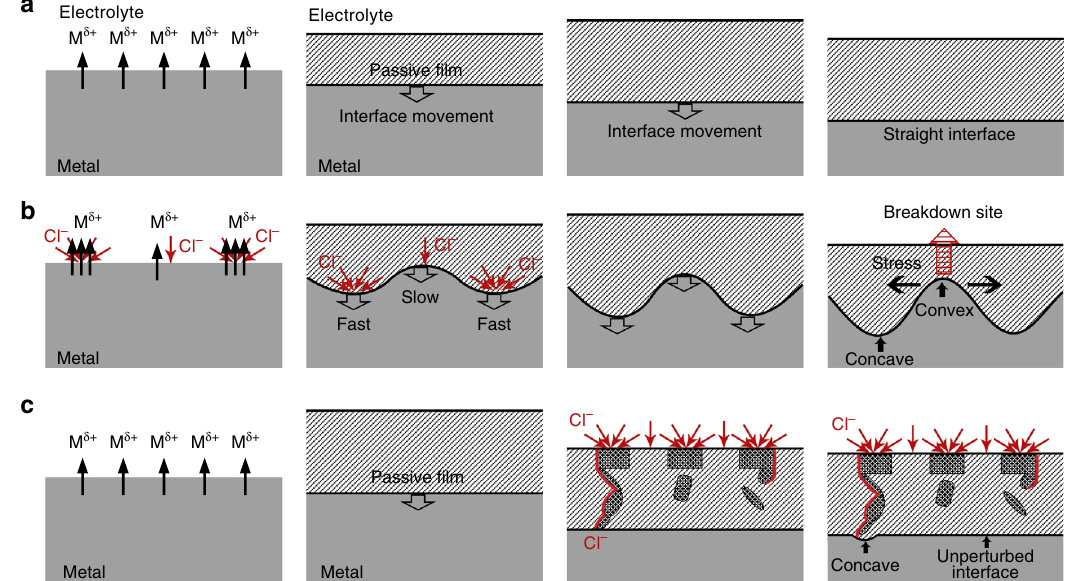
Fig. 7 Schematic maps illustrating interface evolution in the absence and presence of chloride ions. The fi lm growth process involves transport of both injected metal ions from the matrix and oxygen in solution through the barrier layer, causing the metal/ fi lm (Me/BL) interface to move toward the metal matrix side. a In chloride-free (0.5 mol L − 1 H 2 SO 4 ) electrolyte, the austenitic matrix experienced selective dissolution of metal ions (major Fe) in a somewhat homogeneous manner, yielding a straight Me/BL interface at the atomic scale. b In chloride-containing (0.5 mol L − 1 H 2 SO 4 + 0.3 mol L − 1 NaCl) electrolyte, the tendency of chloride ions to be preferentially adsorbed at defective sites yields non-homogeneous adsorption on the bare metal surface. High chloride ion concentration would induce faster dissolution of Fe, which leads to inhomogeneous interface-movement rates, hence differences in passive fi lm growth rates. Such a process yields a passive fi lm with an irregular and undulating Me/BL interface. c When chloride ions attack the as-grown passive fi lm, chloride ions only get to certain interfacial locations by heterogeneously penetrating the as-grown fi lm along the connected path provided by the interfaces between nanocrystals and the amorphous zone. This gives rise to an undulating